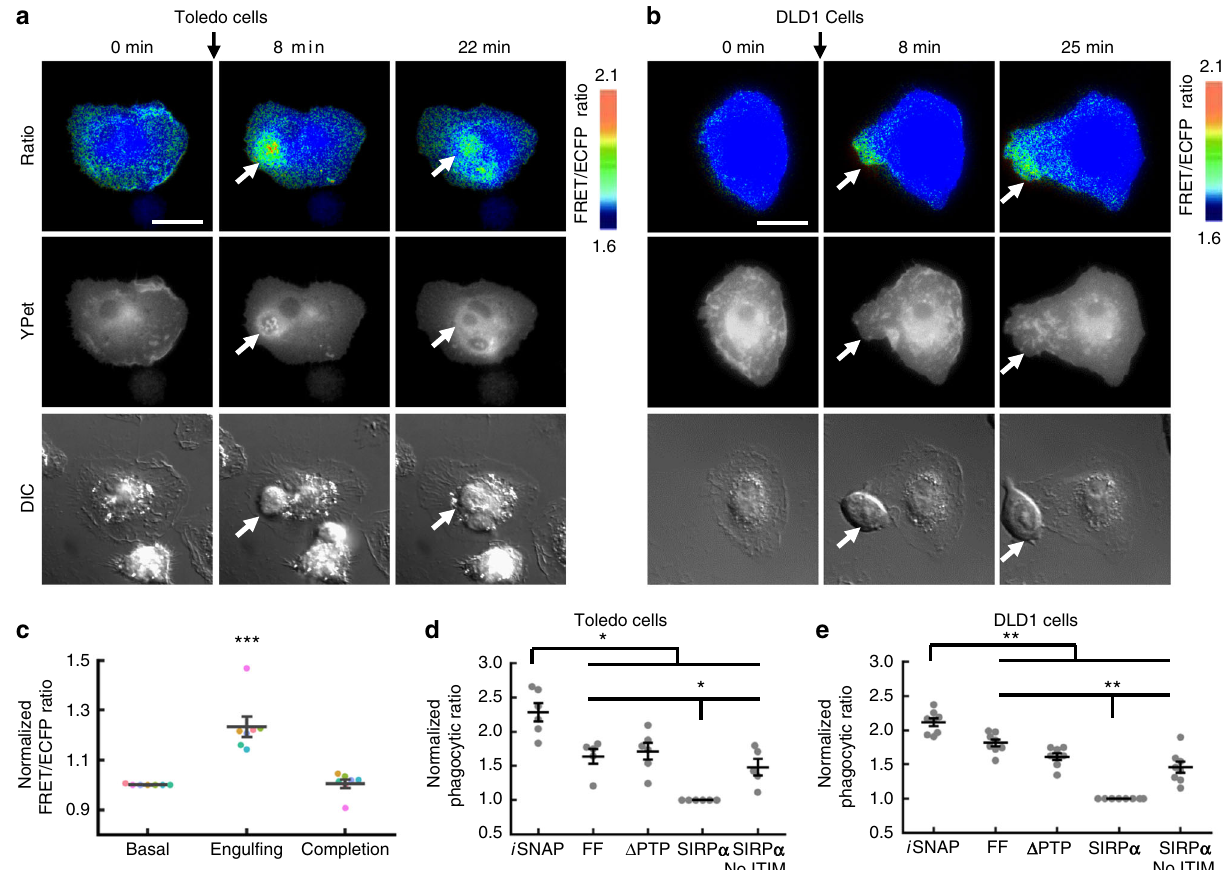
Fig. 3 The activation and function of SIRP α Shp2- i SNAP on phagocytosis of cancer cells. a and b Images of a representative BMDM expressing SIRP α Shp2- i SNAP before and after incubation with 10 μ g ml − 1 rituximab-opsonized Toledo cells a or 2 μ g ml − 1 cetuximab-opsonized DLD1 b at indicated time points. c The FRET ratio of SIRP α Shp2- i SNAP in the BMDM at the region around the engaging Toledo cell before, during and after phagocytosis ( n = 7, 7, 7). The same colored dots represent data obtained from the same cell. d , e Dot plot of normalized phagocytic rate (mean ± s.e.m.) of macrophages expressing different constructs as described in Fig. 2 against rituximab-opsonized Toledo d ( n = 6, 5, 6, 6, 5) or cetuximab-opsonized DLD1 cells e ( n = 8, 8, 8, 8, 8). * P < 0.05, ** P < 0.01, *** P < 0.001 (two-sided Mann – Whitney U -test adjusted for multiple group comparison). Scale bars , 20 μ